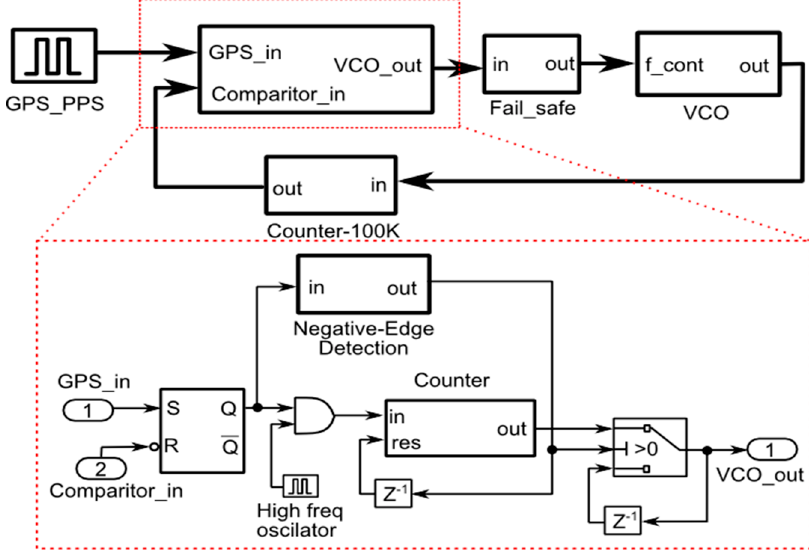
Figure 4. Block diagram for the DPLL using Matlab\Simulink.